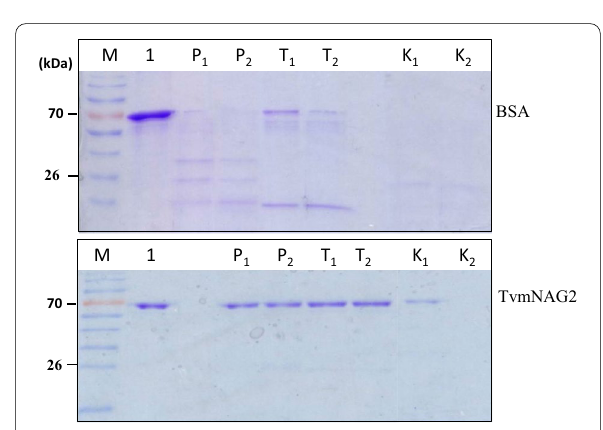
Fig. 7 Effect of protease on TvmNAG2. 2 µg of either TvmNAG2 (below) or BSA (upper) was treated with commercial protease, including papain, trypsin, or protease K at 25 °C for 1 h, followed by SDS‑PAGE analyses. Lane 1, without protease treatment. Lane P 1 and P 2 , papain treatment; lane T 1 and T 2 , trypsin treatment; lane K 1 and K 2 , protease K; whereas 1 , 2 represented 0.6 and 1 µg of commercial protease added into the reaction,